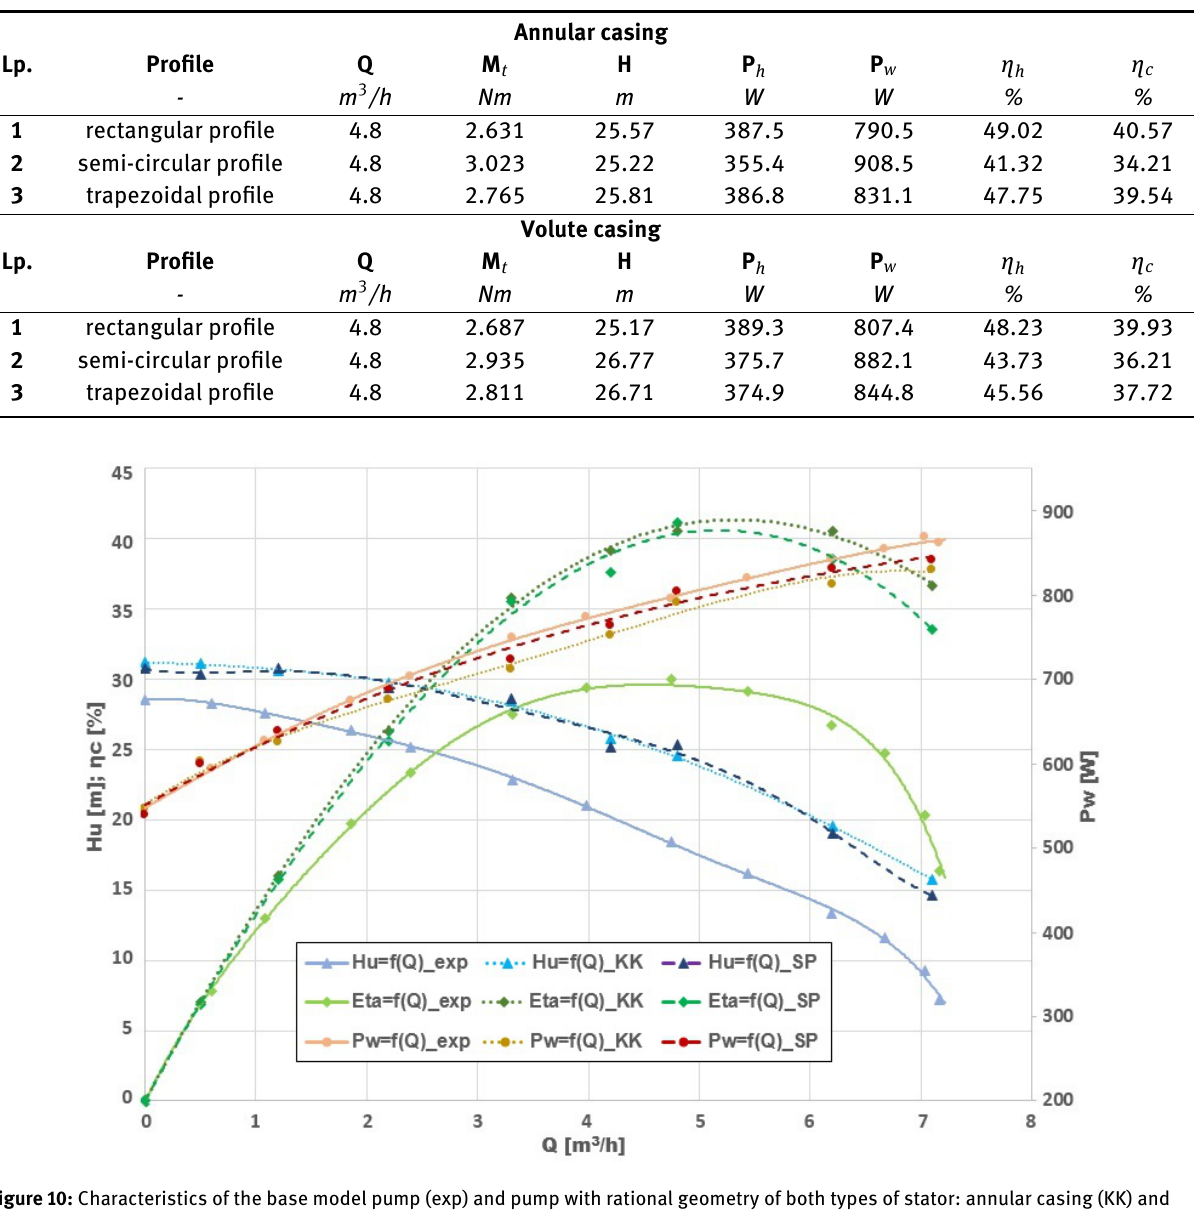
Figure 10: Characteristics of the base model pump (exp) and pump with rational geometry of both types of stator: annular casing (KK) and volute casing